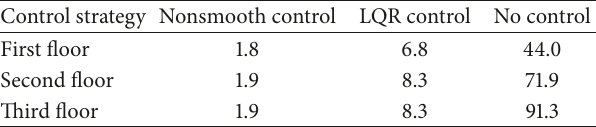
Figure 4: Displacement response of example 1. Table 2: Maximum acceleration of each layer for example 1 (m/s 2